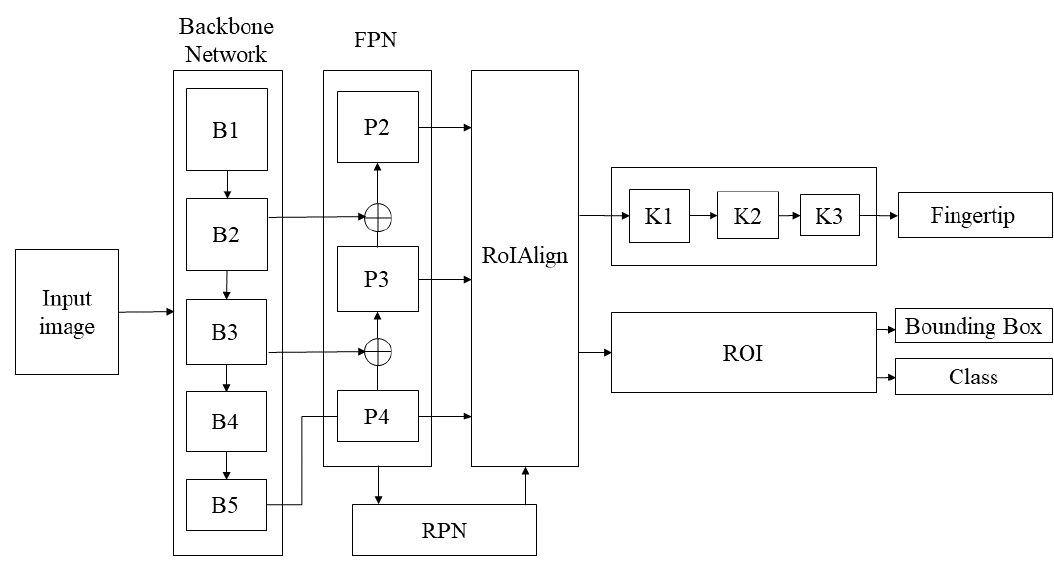
Figure 2. Proposed structure of fingertip detection [20].